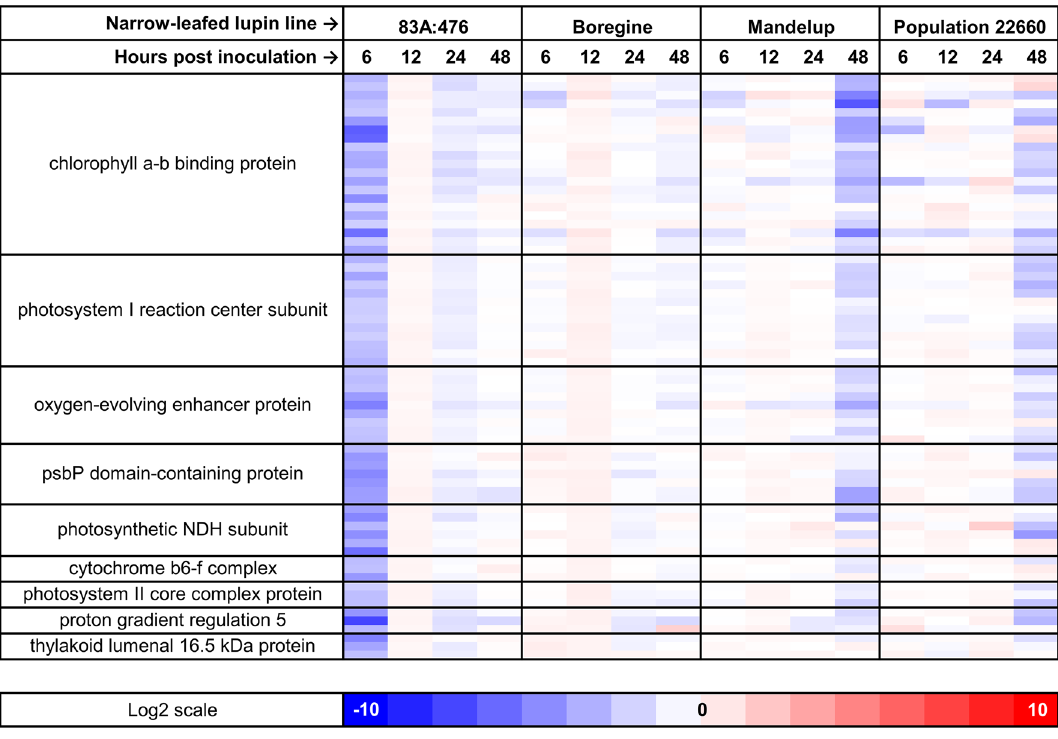
Figure 5. Expression patterns revealed for major components of biological process term “GO:0015979 photosynthesis”. Log2 scale represents the log2(fold-change) values between inoculated ( Colletotrichum lupini , strain Col-08, obtained in 1999 from the lupin field in Wierzenica, Poland) and control (mock inoculation) plants at the same time point. Analyzed narrow-leafed lupin lines were as follows: 83A:476 (resistant, carrying homozygous Lanr1 allele), Boregine (resistant, unknown genetic background), Mandelup (moderately resistant, carrying homozygous AnMan allele), and Population 22660